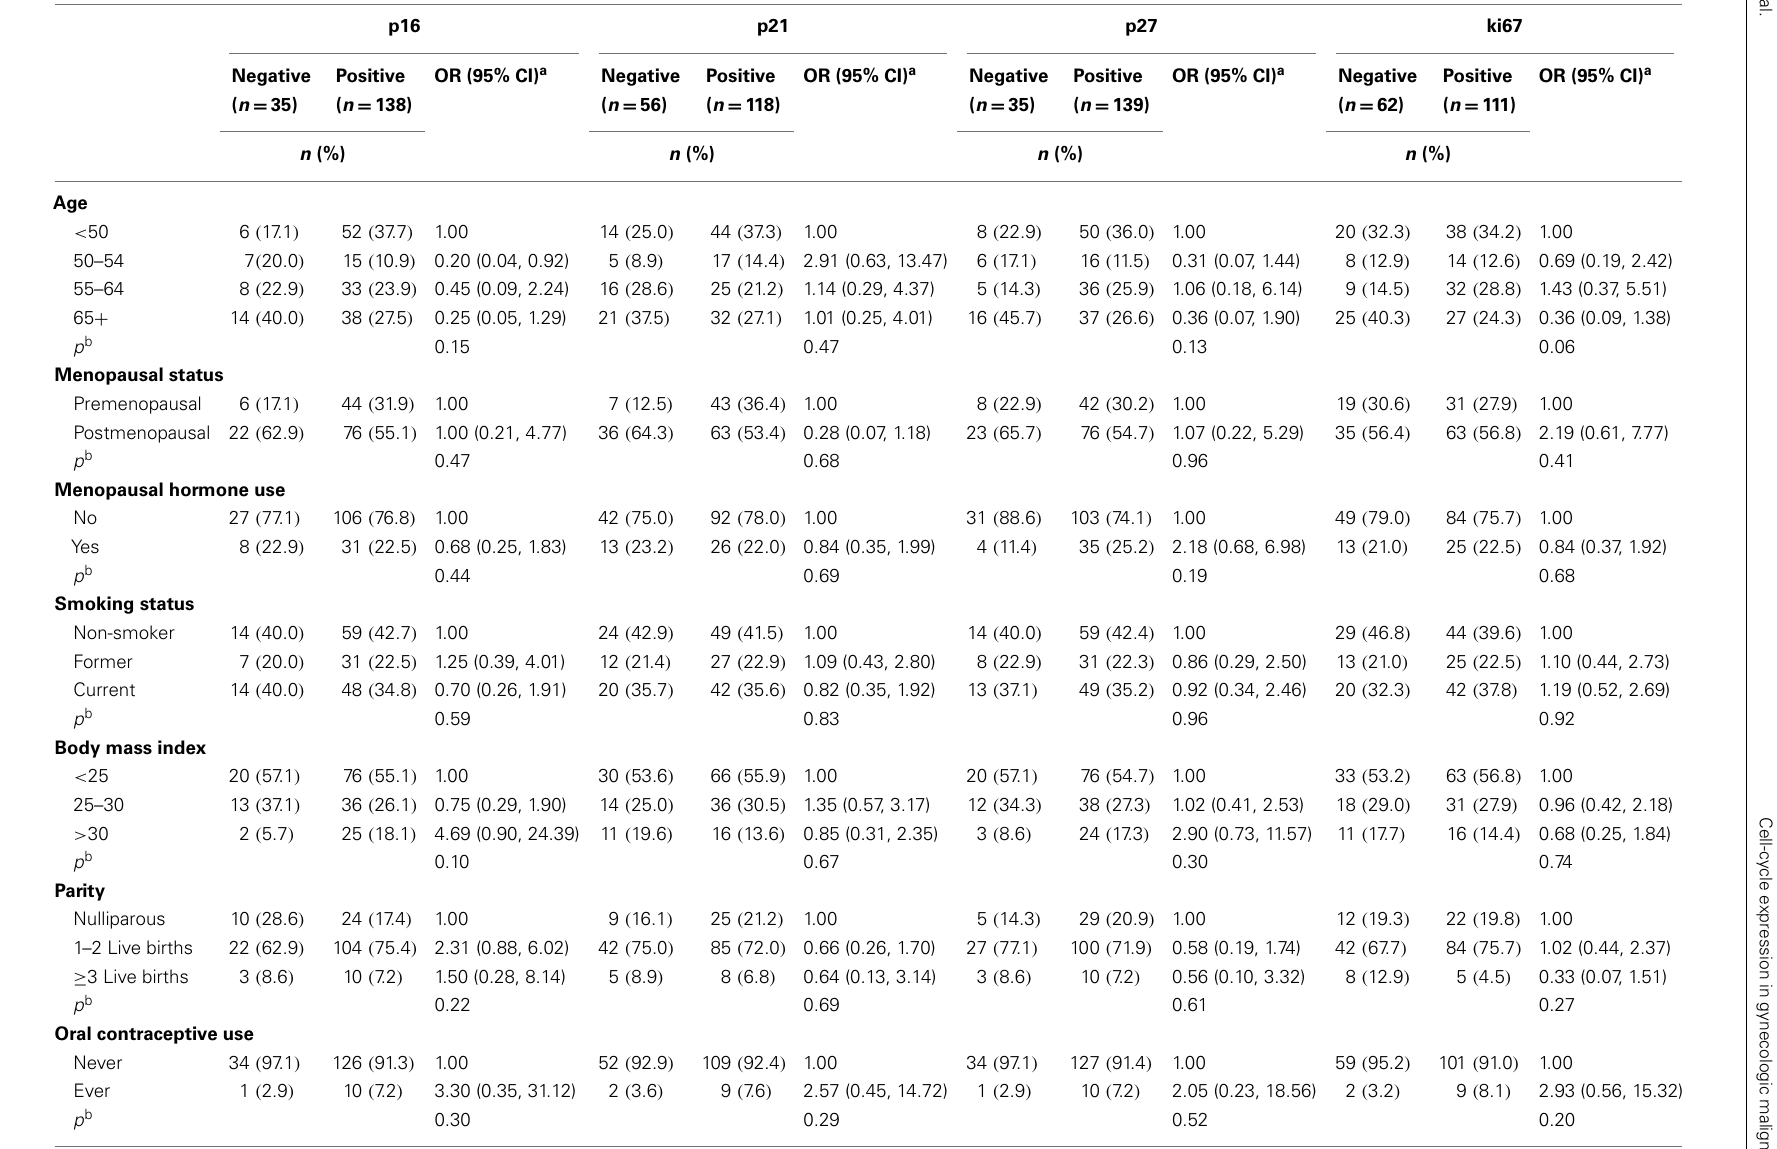
Table 3 |Adjusted odds ratios (ORs) and 95% confidence intervals (CIs) of risk factors and tumor characteristics for positive vs. negative expression of cell-cycle markers among ovarian cancer patients ( n = 175)